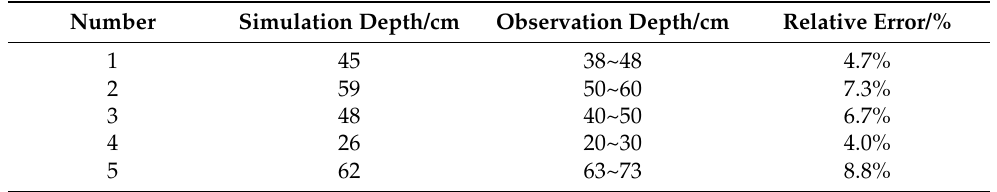
Table 5. Validation results of flood points in the study area on 24 July 2016.